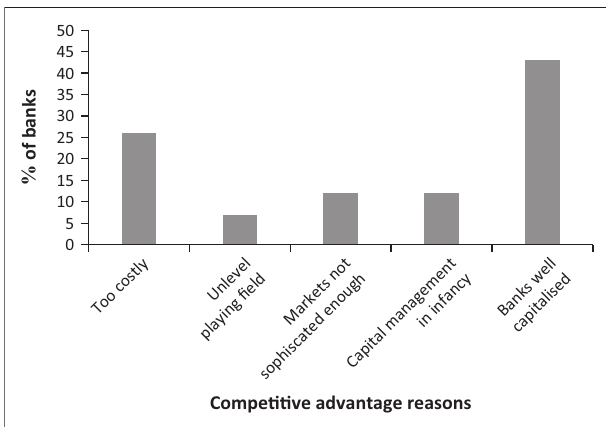
FIGURE 12: Reasons why participants felt an internal capital adequacy assessment process offered a competitive advantage or